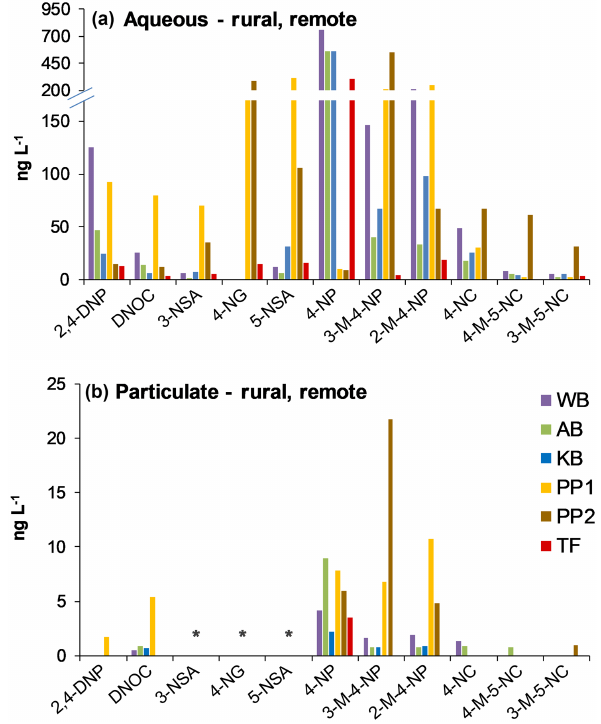
Figure 5. NMAHs in rural and remote snow